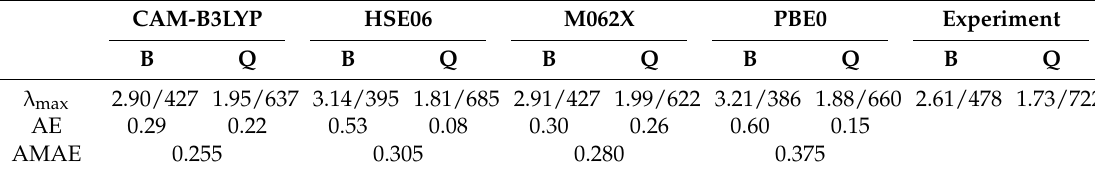
Table 4. The calculated absorption λ max (in nm/eV), the absolute errors (AE, in nm/eV), and the arithmetic mean absolute errors (AMAE, in eV) of B and Q bands for DTBC with different fuctionals in